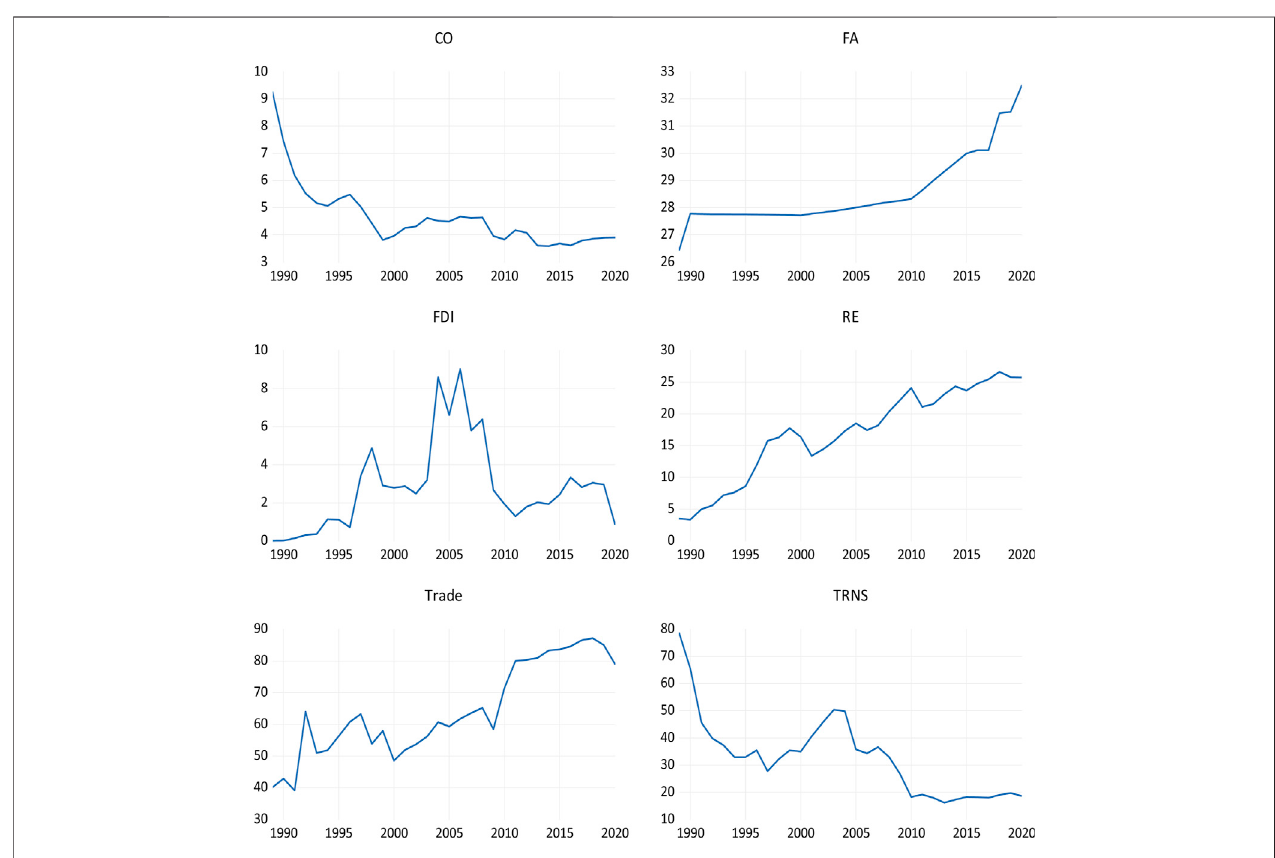
FIGURE 1 | Graph of level data from 1989 to 2020 (Source: The World Bank, 2021).